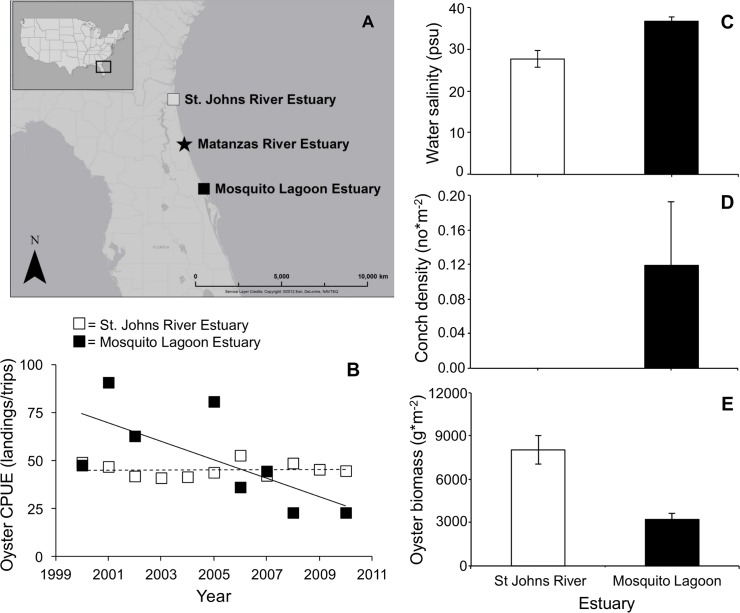
In an estuary north and south of the Matanzas River estuary, variation in the catch per unit effort of oysters, water salinity, crown conchs, and biomass of oyster reefs.(A) Map of the Floridian ecoregion illustrating the location of the Matanzas River Estuary (star symbol) as well as a northern (open square) and southern (closed square) estuary. (B) The annual CPUE of oysters from 2000 to 2011 for the northern and southernmost estuaries. (C) Mean (SE) salinity of water in the northernmost and southernmost estuary. Mean (SE) abundance of conchs (D) and oyster biomass (E) in the northernmost and southernmost estuaries of this ecoregion. Asterisks denote significant differences (p < 0.05). All maps were produced in ArcGIS by E. Pettis.